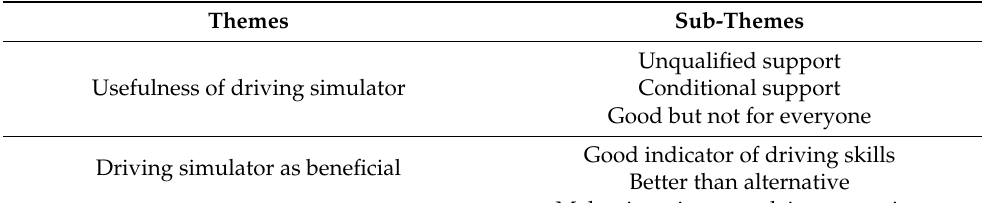
Table 3. Summary of qualitative data analyses regarding caregivers’ opinions about the use of driving simulators to assess driving